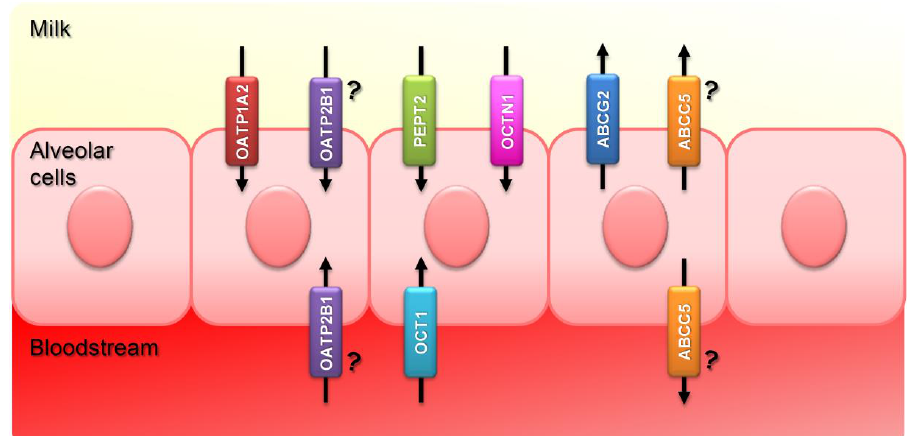
Figure 1. Subcellular localization of the main ABC- and SLC-transporters upregulated in the mammary gland during lactation. The apical localization of ABCG2 and PEPT2 in the mammary gland has been confirmed in previous studies [17,19]. The localization of OATP1A2, OCT1 and OCTN1 suggested in this figure is based on their localization in other tissues [35 – 39]. OATP2B1 and ABCC5 are localized apically or basolaterally, depending on the tissue [40 – 46]; however, their specific localization in the mammary gland is still unclear.